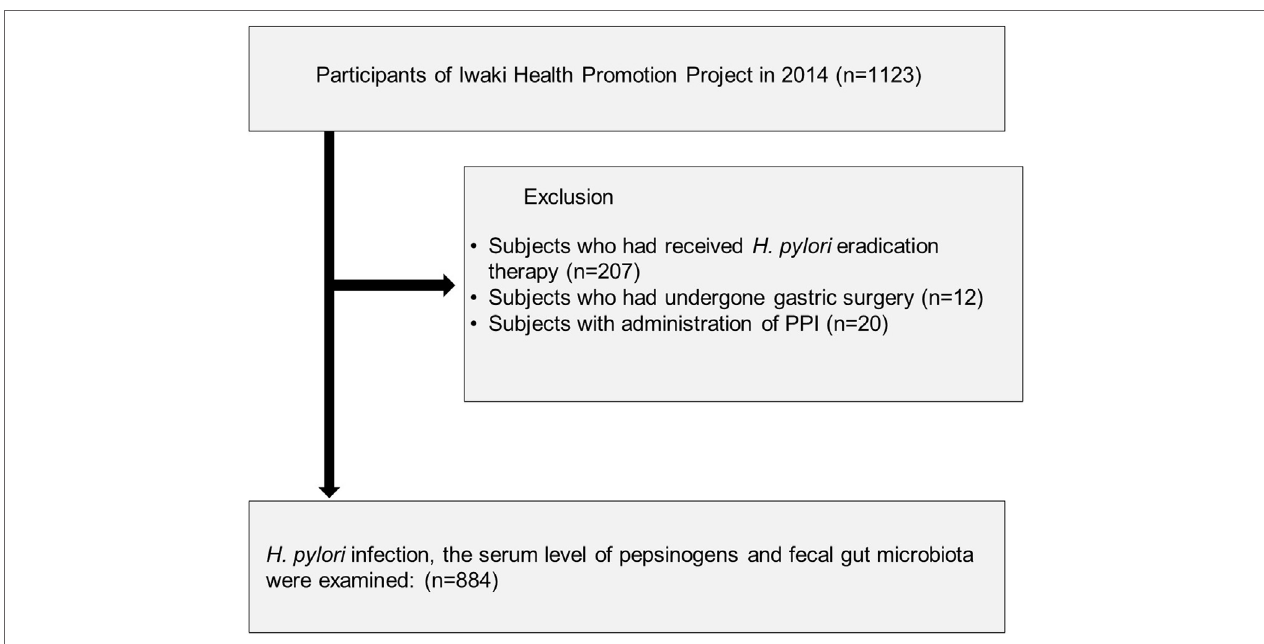
FigUre 1 | Study flow of subjects. A total of 884 subjects were enrolled from 1,123 adults who participated in the Iwaki Health Promotion Projects in